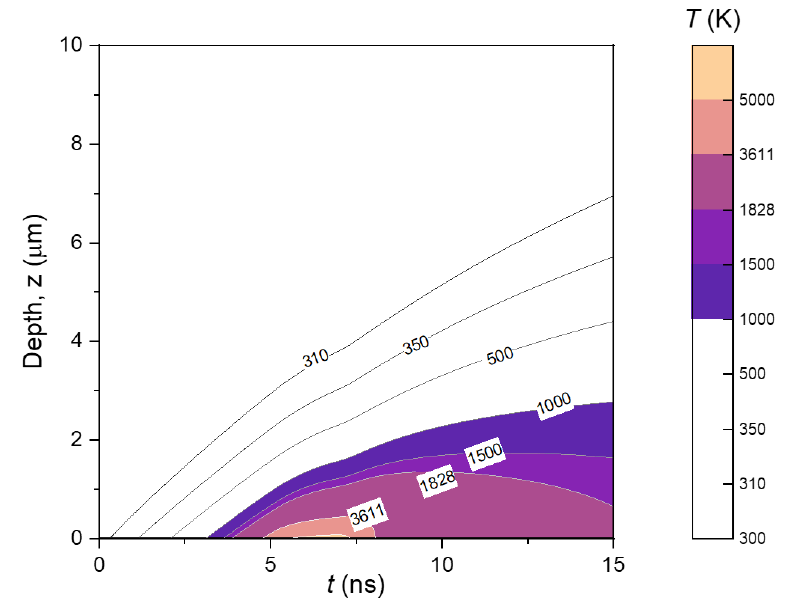
Figure 4. Temperature distribution inside the YIG target during laser pulse irradiation ( t ≤ 15 ns) calculated for maximum depth z = 10 µm. Numerical parameters used as the same as the result shown in Figure 3.